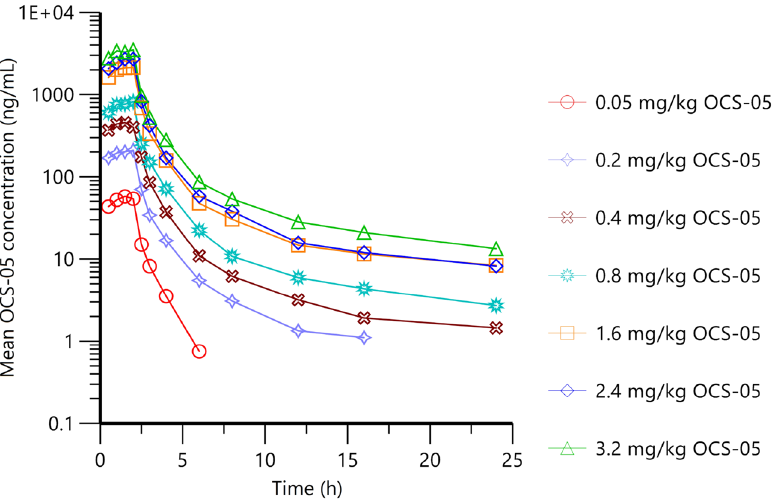
Figure 1. Summary of derived pharmacokinetic parameters following single dose administration of OCS-05 (i.v. infusion) to healthy male and female subjects.